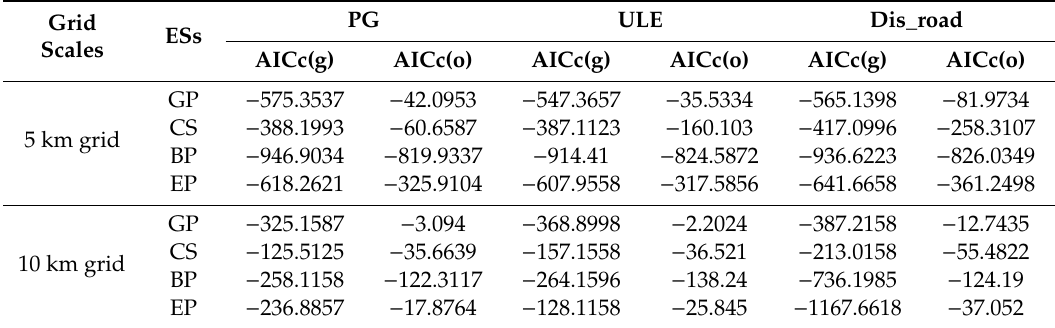
Table 4. The corrected Akaike information criterion (AICc) values of ordinary least squares (OLSs) and geographically weighted regressions (GWRs) for the relationships between ecosystem services changes and urbanization